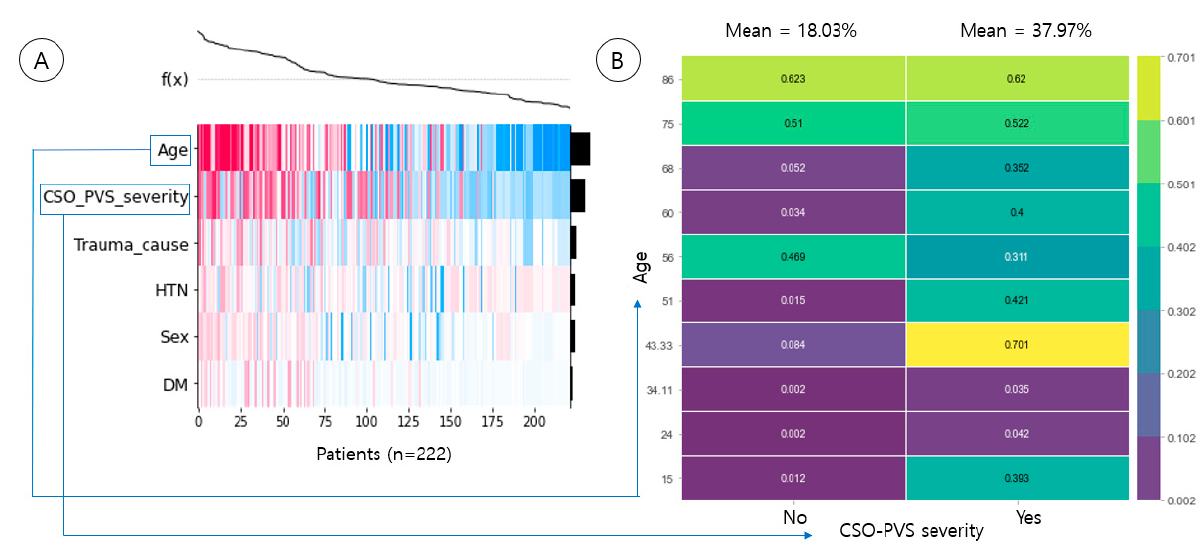
Figure 3. Feature importance heatmap and individual feature analysis using partial dependence analysis: ( A ) among the risk factors, age and CSO-PVS severity highly impacted the de novo hygroma status. Red and blue are positive and negative impact, respectively, and the color fading is the difference in intensity of impact change.; and ( B ) dependence analysis result between CSO-PVS severity and age. Most patients aged more than 86 years had a high correlation (62%) with CSO-PVS severity for the development of hygroma. Patients who had no or mild CSO-PVS severity showed lower dependency (mean 18.03%) over the entire age, but patients with high CSO-PVS severity showed higher dependency across age group (mean 37.97%). Note: trauma cause indices: 1, slip down; 2, out-car traffic accident; 3, syncope; 4, hitting; 5, bicycle traffic accident; 6, in-car traffic accident; 7, slip down; f(x), model function (y) of contribution for x; HTN, hypertension; DM, diabetes.